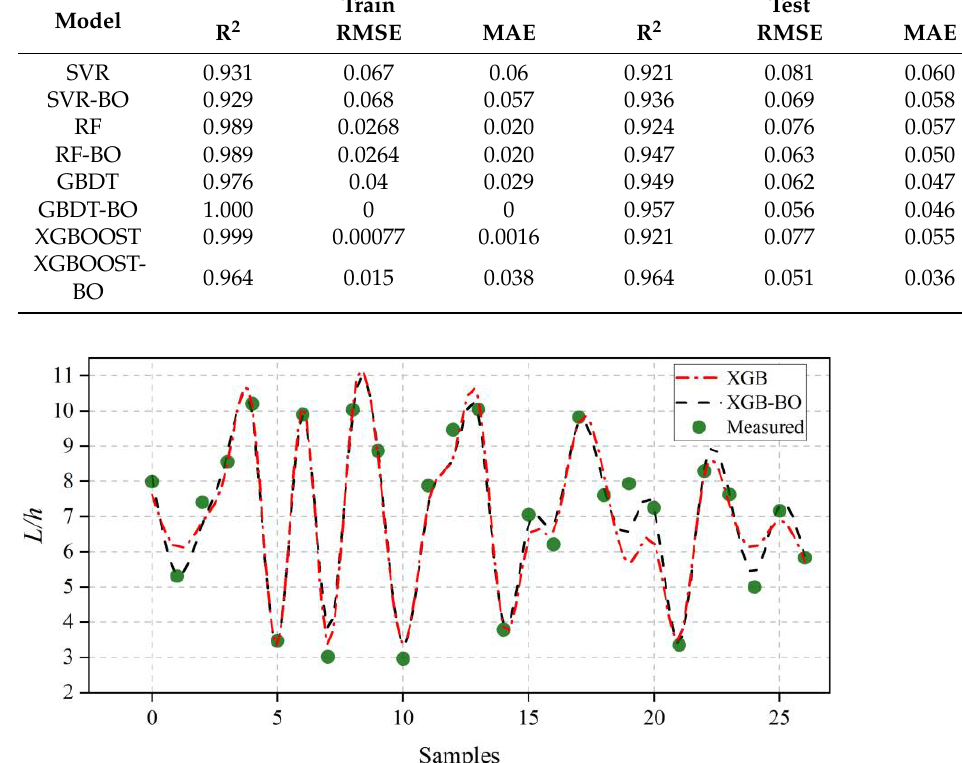
Figure 4. The prediction results of the optimal XGB-BO and XGB regressor on the test set.